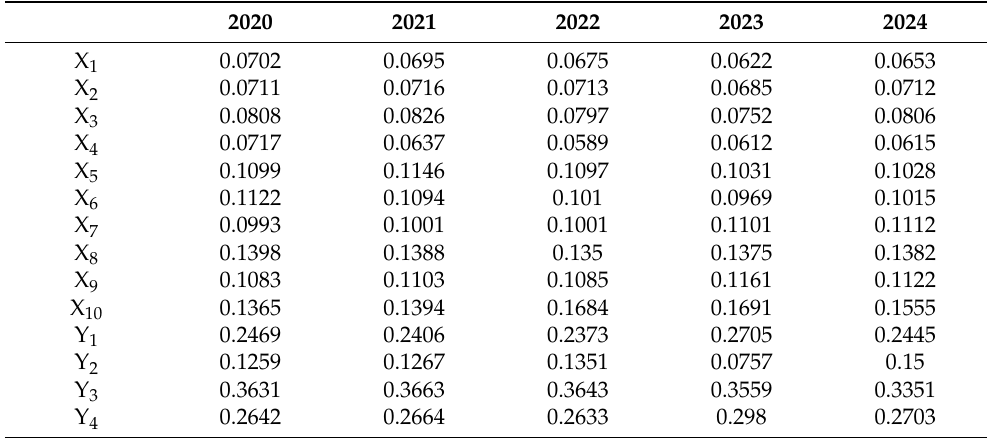
Table A2. Index weight in the elderly care service resource supply/demand system from 2020 to 2024 (forecast